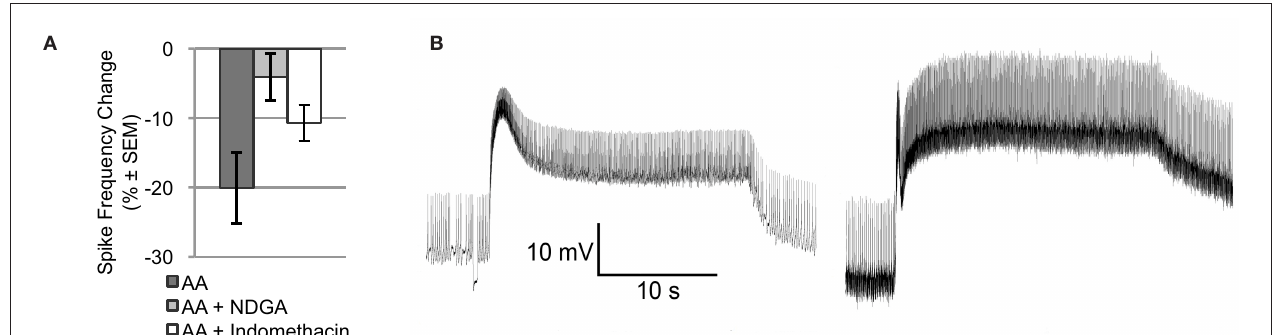
another cell exposed to indomethacin (right), both in the absence of AA. Note the enhanced light-response of the indomethacin treated cell. This